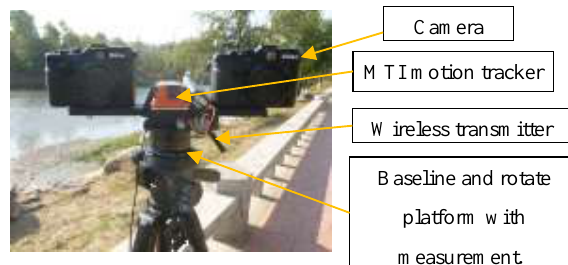
Figure 6. A specialized device we built to build stereo panorama.